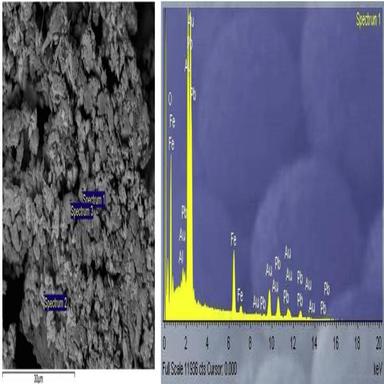
SEM-EDS analysis of the sample Gornje Polje Malo Rudare.